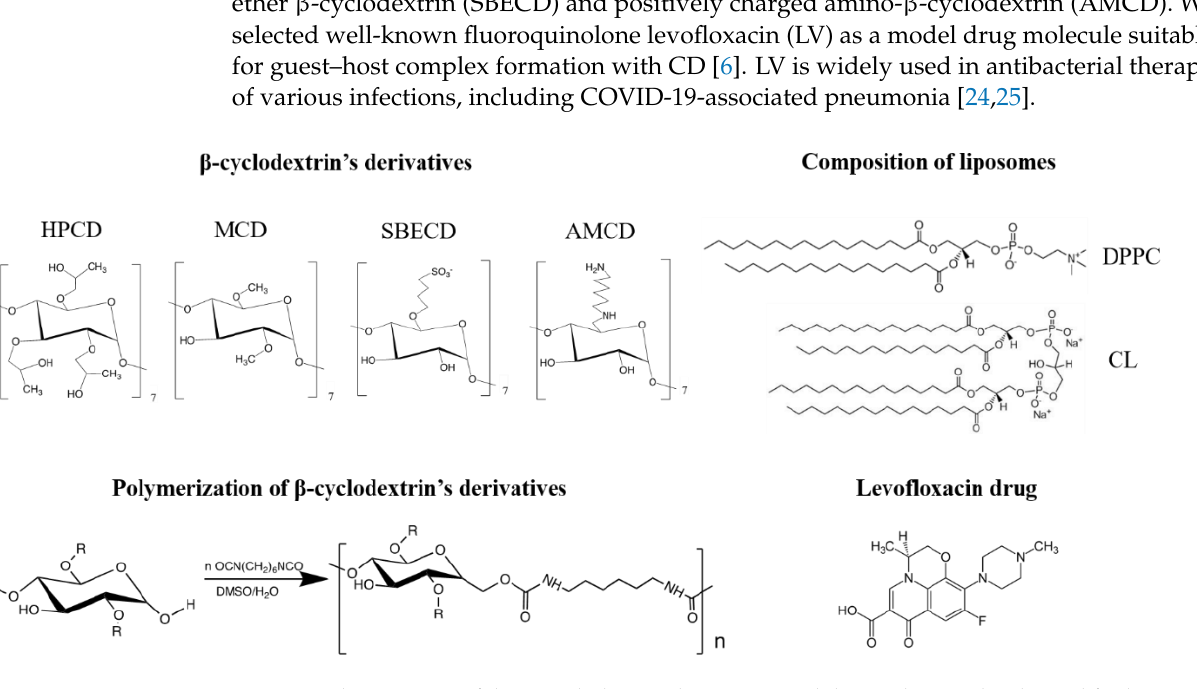
Figure 1. The structure of the β -cyclodextrin derivatives and their polymers, lipids used for liposome production and